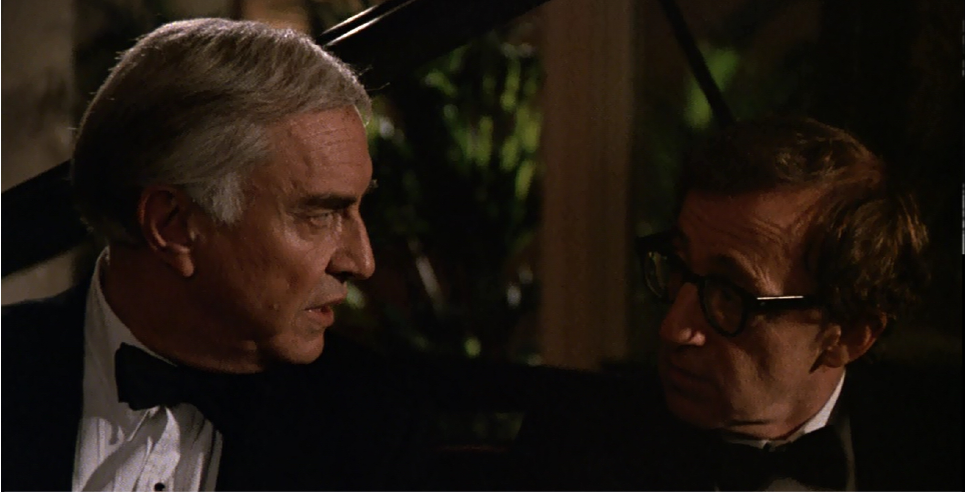
Figure 4: Judah Rosenthal and Clifford Stern (Woody